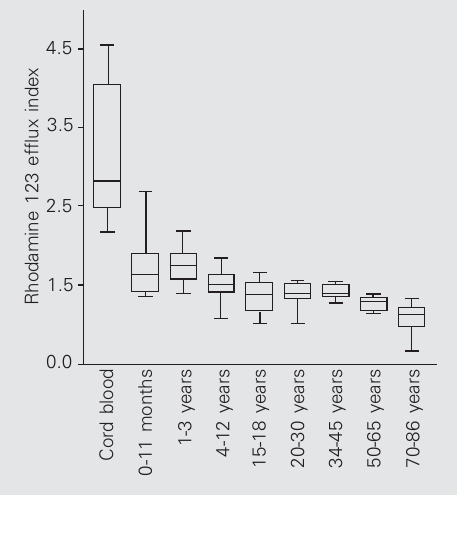
Figure 2. Variation of P-glyco- protein function in T CD8+ lym- phocytes with age. P-glycopro- tein function is reported as the ratio of rhodamine 123 mean fluorescence in the presence and in the absence of verapamil (rhodamine 123 efflux index). P- glycoprotein functional expres- sion was highest in cord blood, progressively decreasing with age, reaching the lowest values in the 70- to 86-year